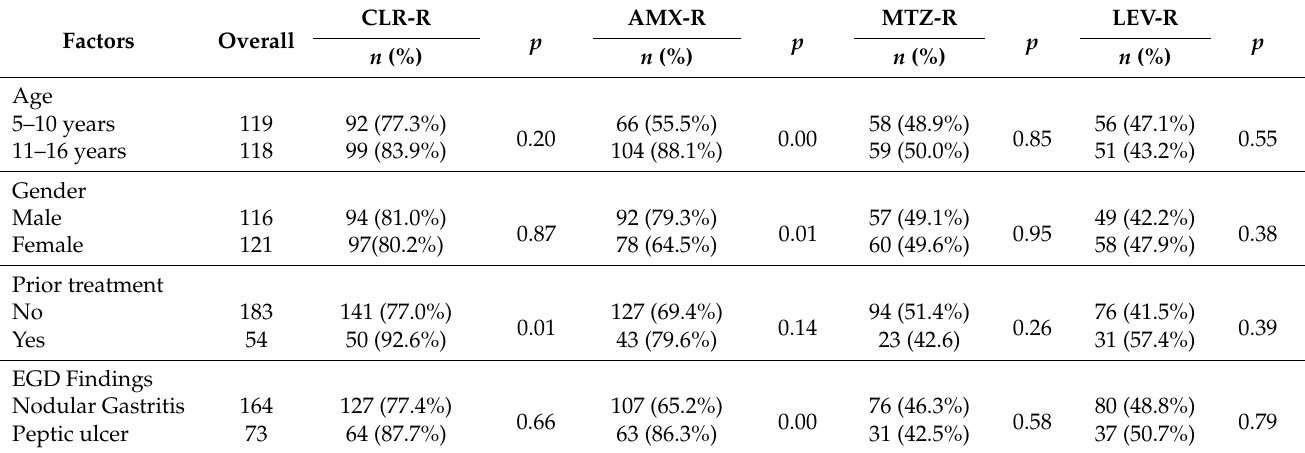
Table 3. Factors associated with antimicrobial resistance to CLR, AMX, MTZ, and